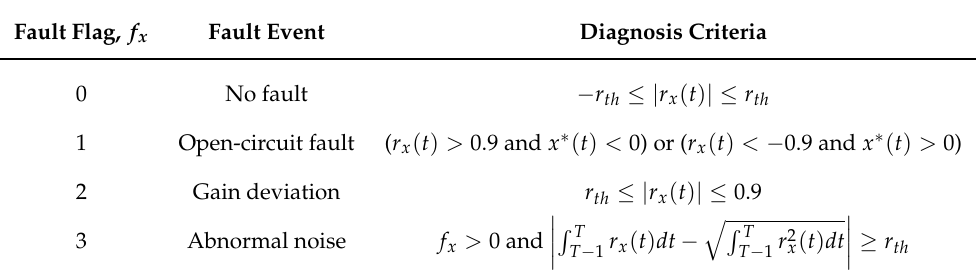
Table 1. Sensor Fault Diagnosis Criteria ( x = i L , v dc ).